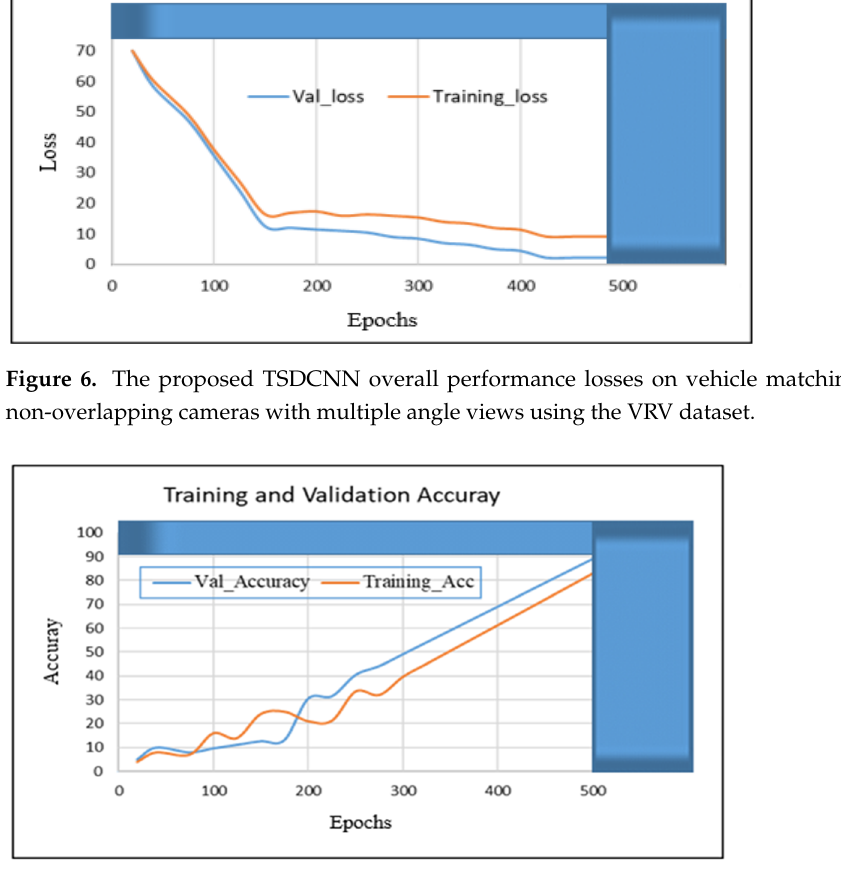
Figure 7. The proposed TSDCNN with 89.40% overall accuracy performance on vehicle matching rates across non-overlapping cameras with multiple angle views using the VeRi776